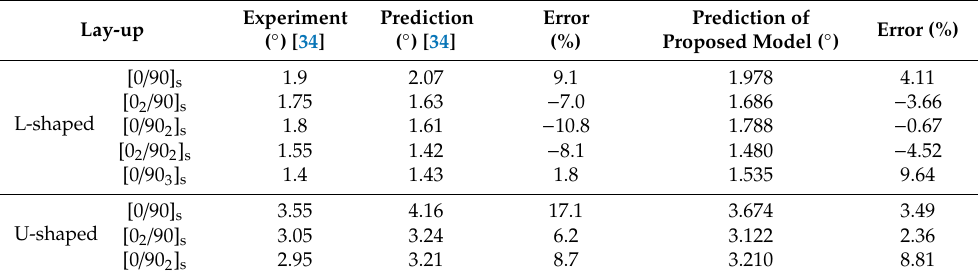
Table 6. Comparison of model prediction